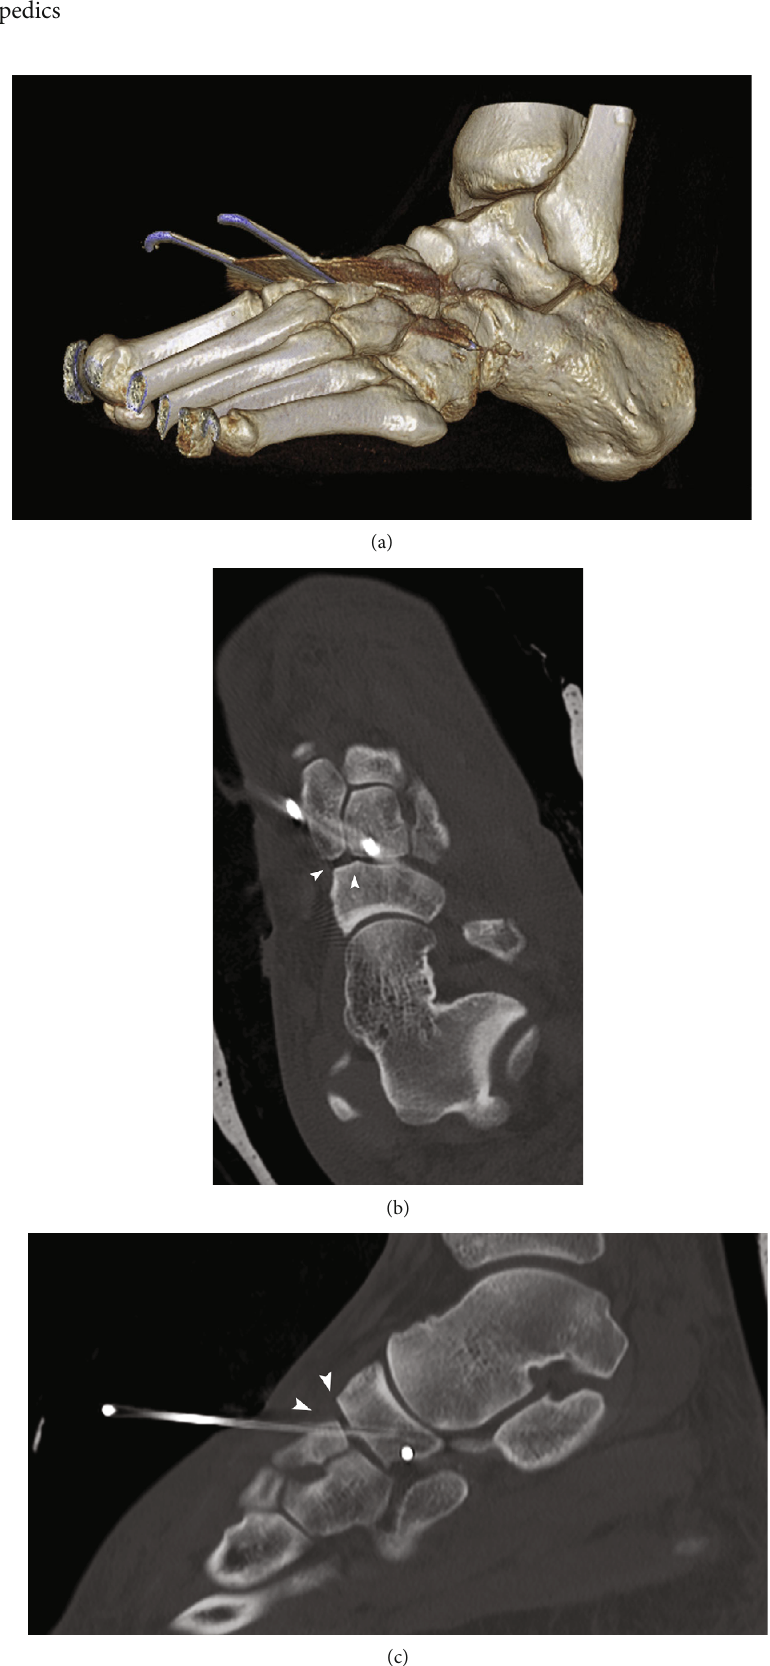
Figure 4: (a) Dorsolateral volume-rendered CT of the left foot shows the incomplete reduction of the calcaneocuboid joint. (b) Oblique and (c) lateral multiplanar reformatted CT show the incomplete naviculocuneiform reduction (white